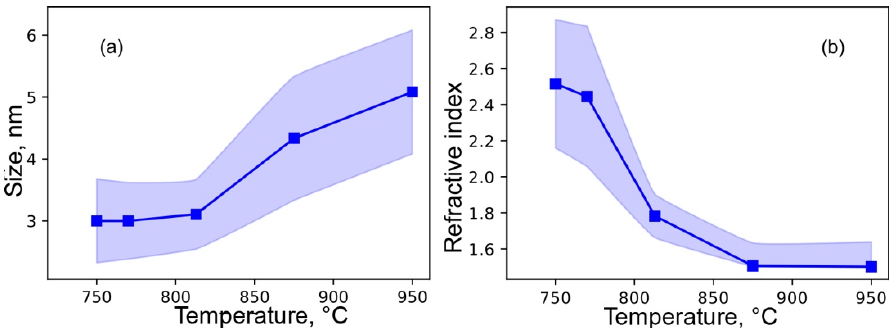
Figure 13. Illustration of the obtained size distributions ( a ) and glass refractive index ( b ) for gold NPs in samples obtained at heat treatment temperatures from 750 to 950 °C. The solid line corresponds to the parameter μ , and the shaded areas correspond to the deviation from μ by ±0.5 σ .